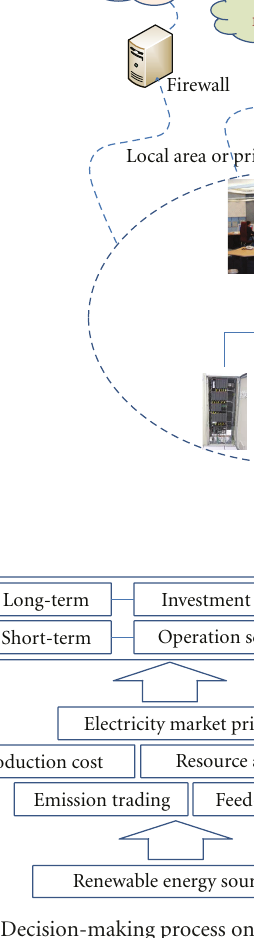
Figure 3: Decision-making process on renewable energy.